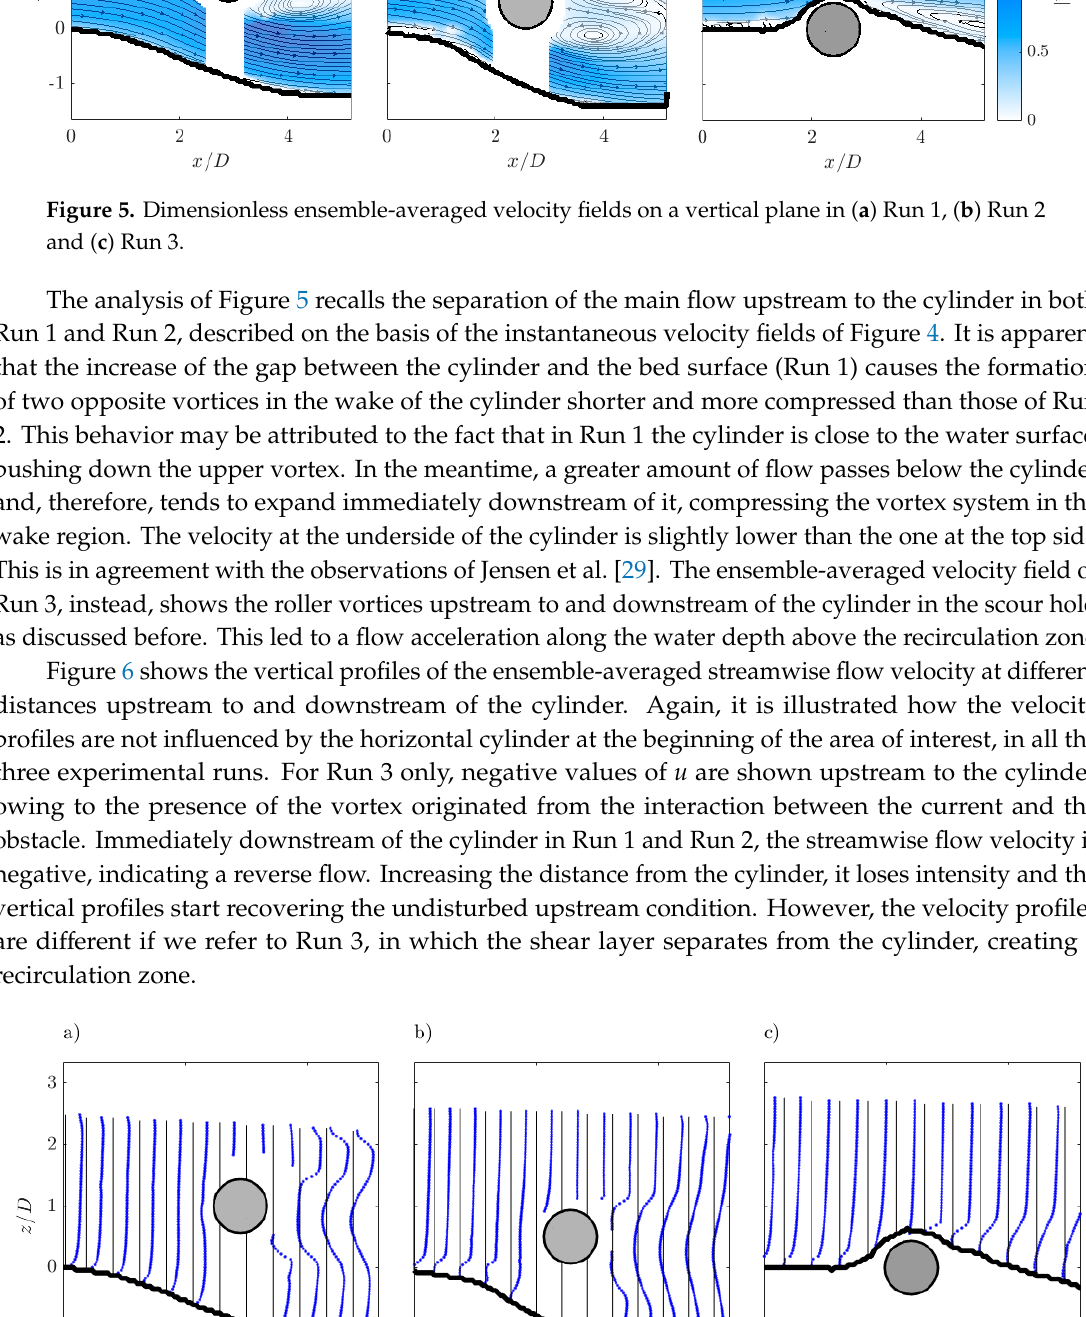
Figure 6. Vertical profiles of the ensemble-averaged streamwise flow velocity at different streamwise distances in ( a ) Run 1, ( b ) Run 2 and ( c ) Run 3.